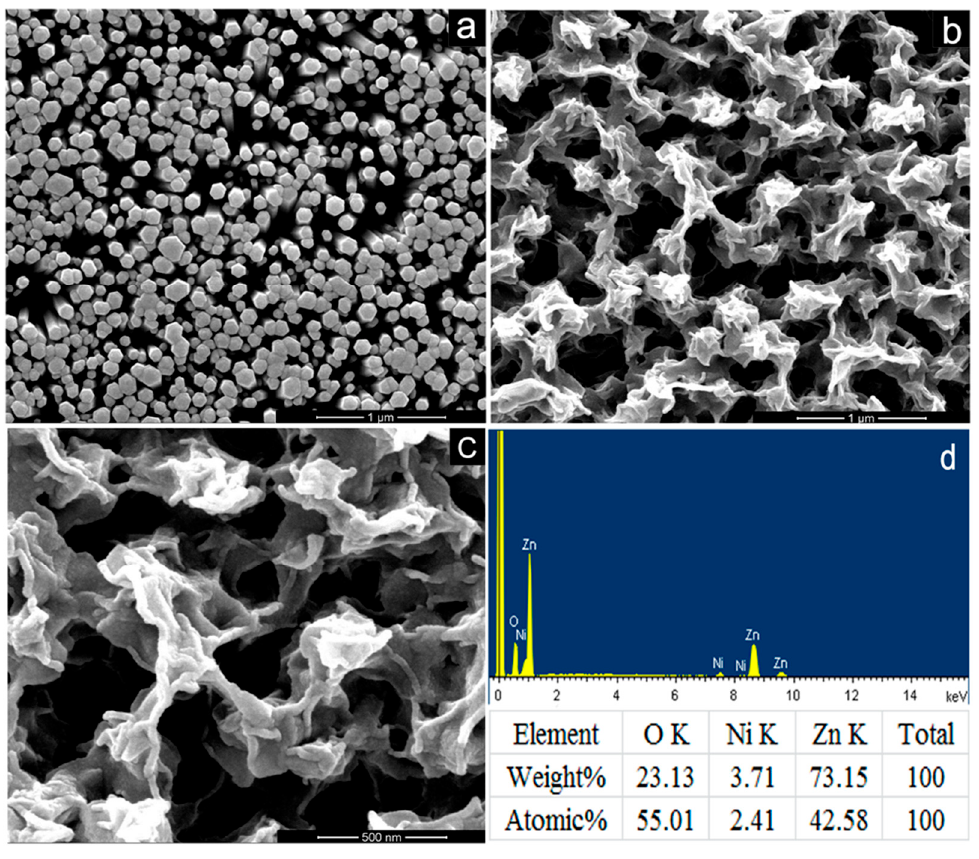
Figure 1. SEM images of ( a ) pure ZnO NRs, ( b , c ) NiO / ZnO heterostructures and ( d ) EDS of NiO / ZnO heterostructures.